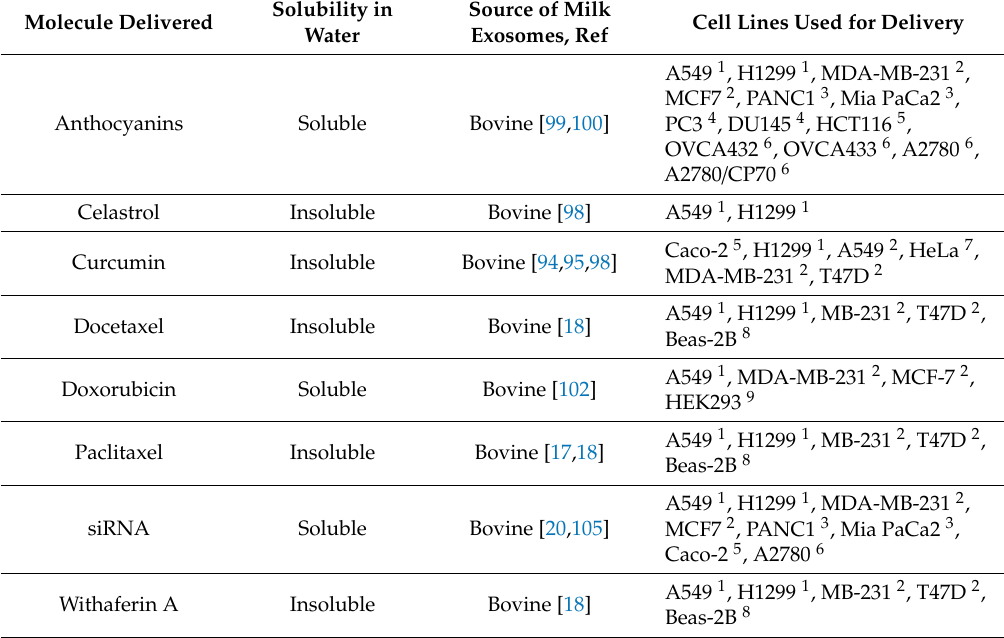
Table 4. Biologically and therapeutically significant molecules delivered with milk